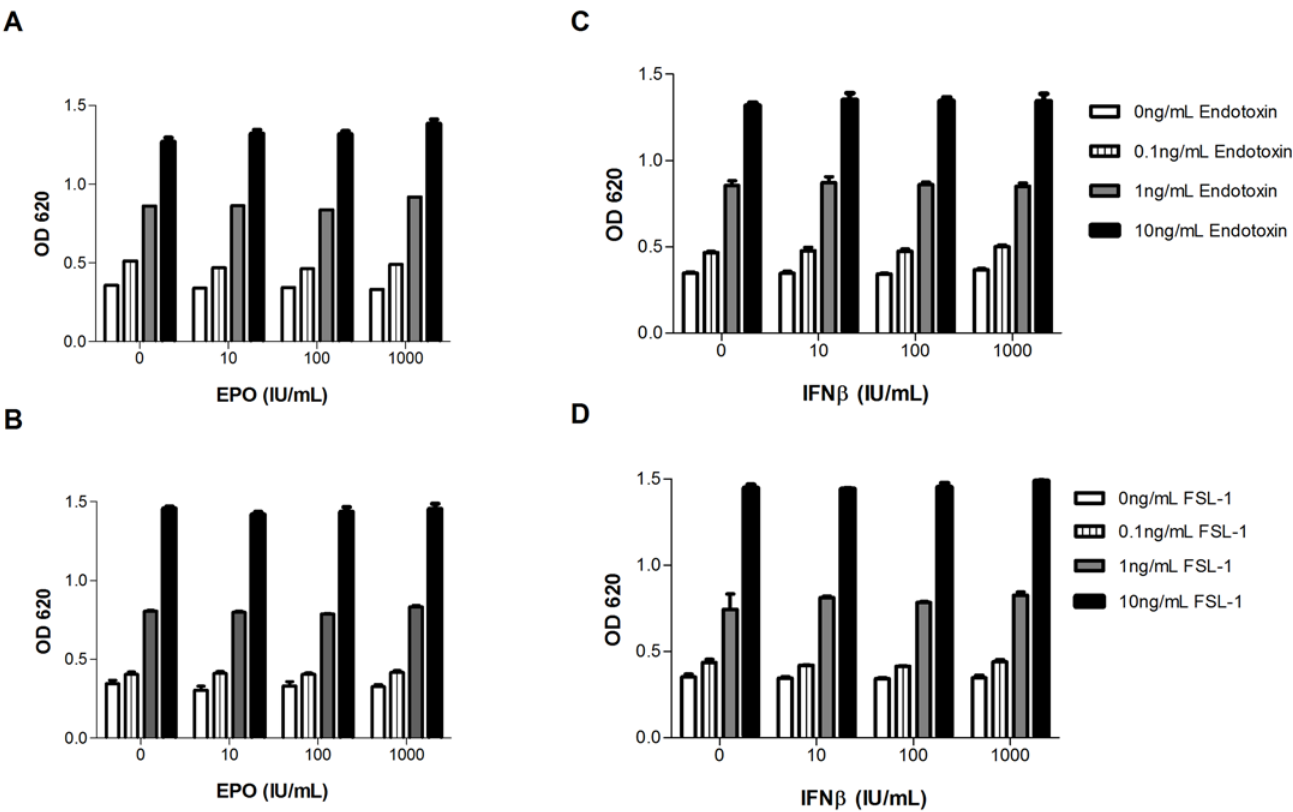
Fig 4. Effect of therapeutic protein concentration on screening assay. Titration of endotoxin and FSL-1 were performed in the presence of increasing concentration of EPO ( A-B ) and IFN- β ( C-D ) using RAW-BLUE cell. Supernatant was collected after 24h and NF- κ B activation was measured by the addition of QUATI-BLUE medium and OD was read at 620. All samples were in triplicate. Data points represent mean ± SD.